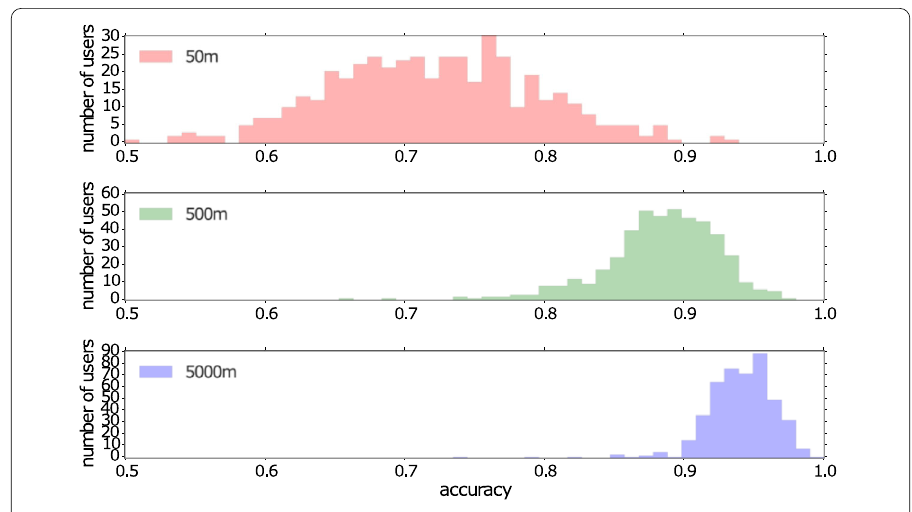
Figure 3 Effect of spatial granularity of the accuracy for the Markov model in the next-cell formulation. Each panel shows the accuracy for a different spatial bin size: 50 m, 500 m and 5000